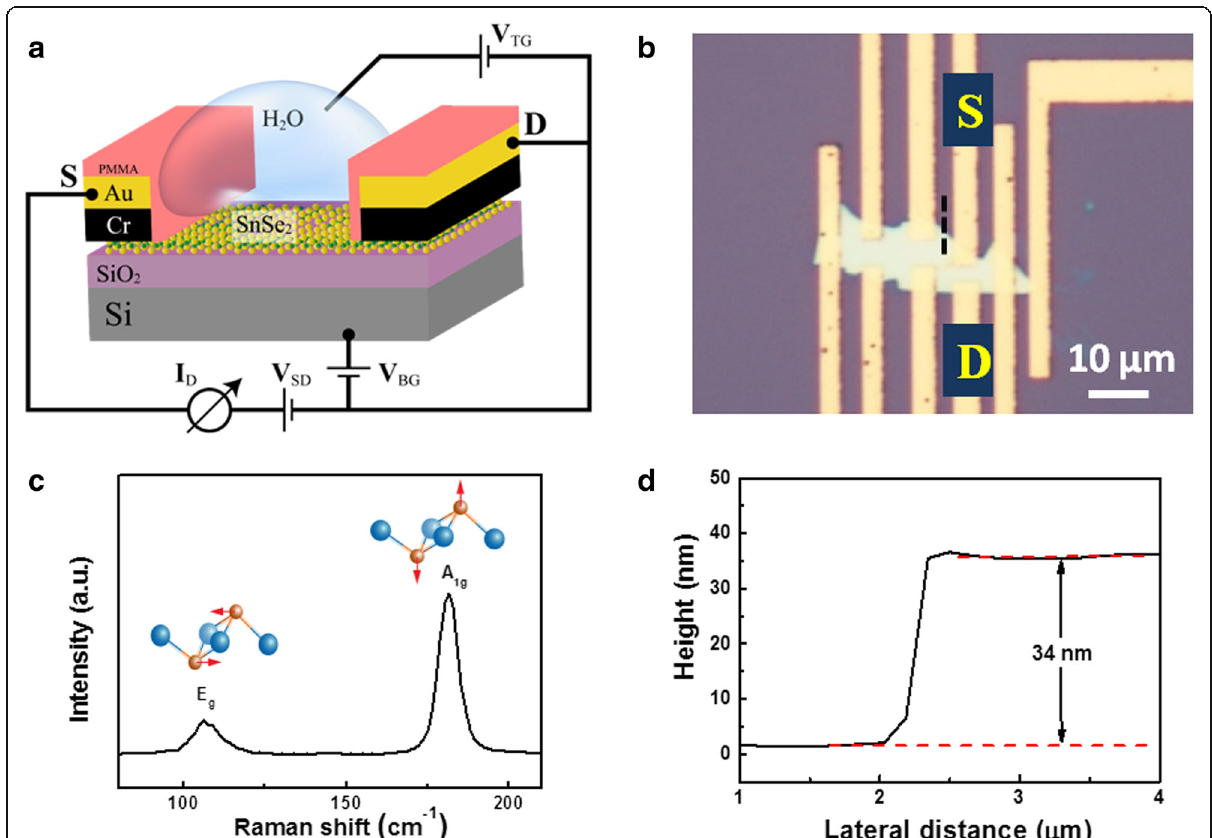
Fig. 1 An illustration of SnSe 2 phototransistor device and some basic characterizations about the SnSe 2 flake. a Schematic illustration of a SnSe 2 field-effect transistor device. b Optical image of a SnSe 2 flake with S and D denoting the source and drain electrodes under study, respectively. c Raman spectrum of a SnSe 2 flake. d A height profile extracted from the black dotted line (shown in Fig. 1 b ) in AFM